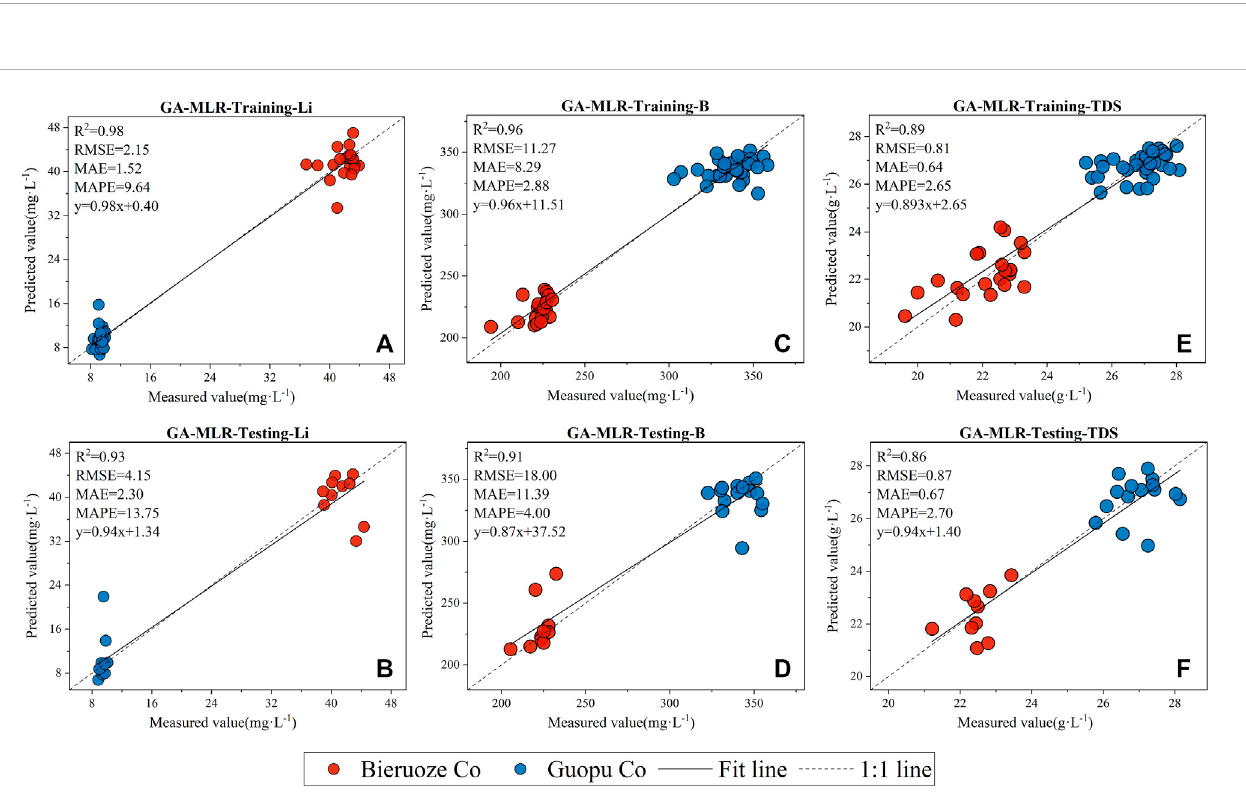
FIGURE 6 FittingofmeasuredandpredictedvaluesusingGA-MLRmodels.EstimatedLicontentbasedonthetraining (A) andtesting (B) .EstimatedBcontentbased on the training (C) and testing (D) . Estimated TDS content based on the training (E) and testing (F)